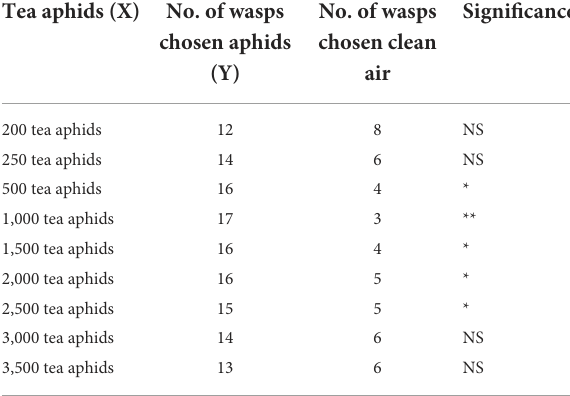
TABLE 4 Number of Aphelinus sp. attracted to tea aphids vs. clean air in Y-tube olfactometer assay. Tea aphids (X)